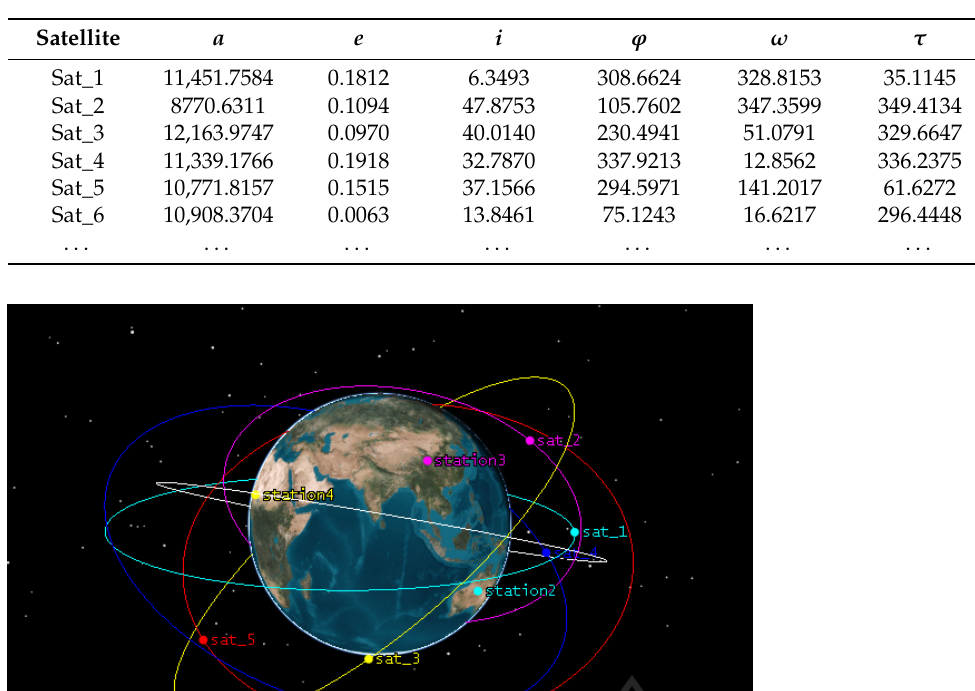
Table 2. Orbit paraments.